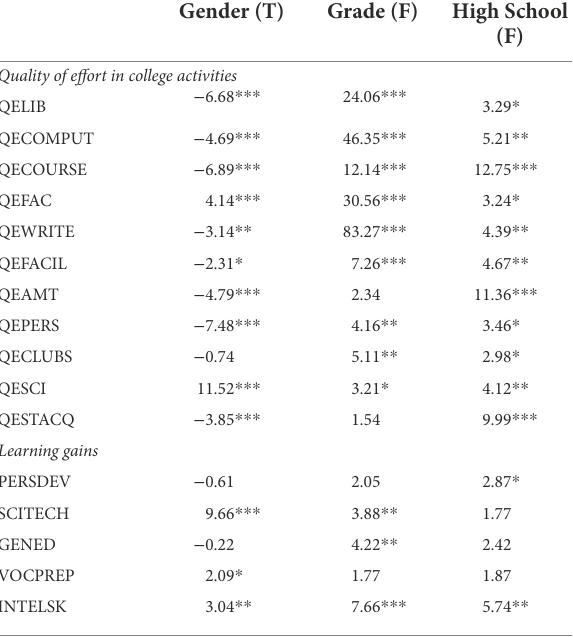
TABLE 2 Differences in quality of effort in college activities and learning gains of Chinese undergraduates. Gender (T) Grade (F) High School